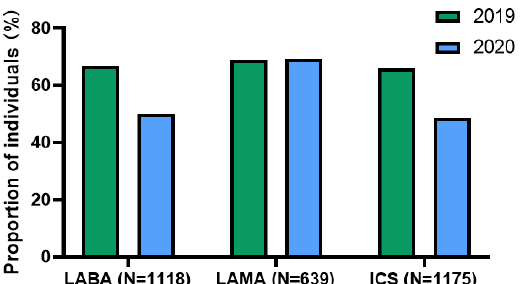
Figure 1. Proportion of individuals with high adherence to their controllers. Abbreviations: